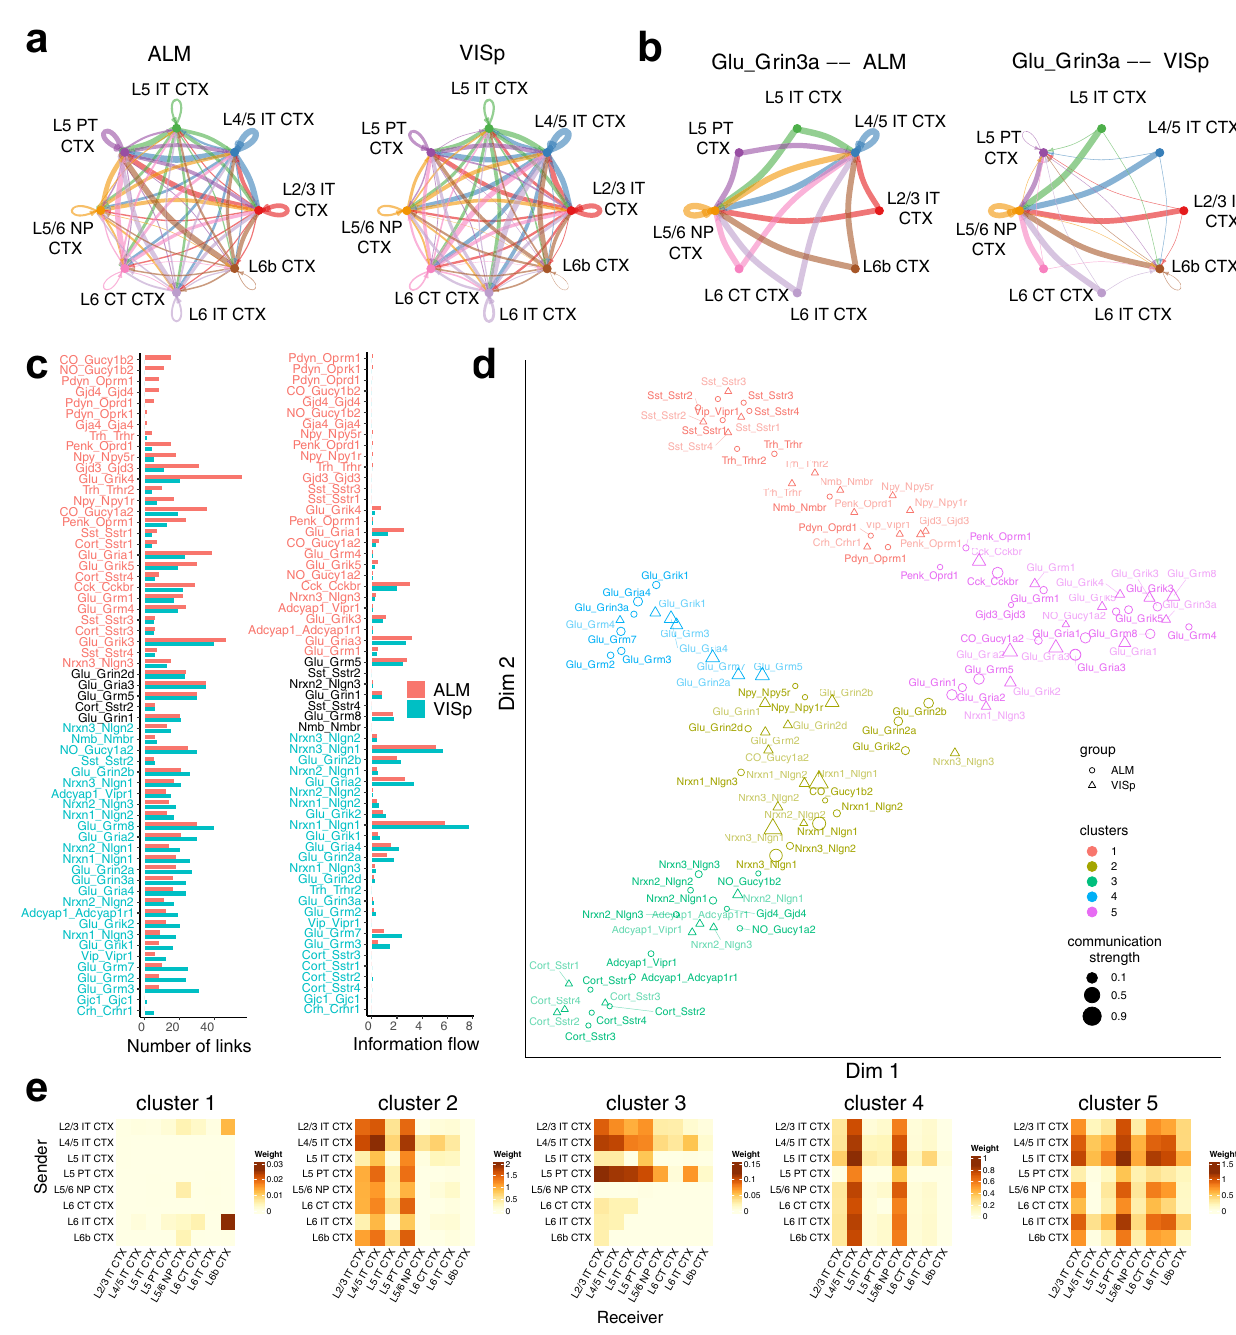
Fig. 5 | Comparison analysis of interlaminar excitatory communication net- works for ALM and VISp. a The aggregated interlaminar excitatory communica- tion networks for ALM(leftpanel)and VISp(right panel).The aggregationmethod usedis “ weight ” . b Theindividualinterlaminarexcitatorycommunicationnetworks ofGlu-Grin3aforALM(leftpanel)andVISp(rightpanel). c Barchartscomparingthe number of links (left panel) and information fl ow (right panel) between ALM and